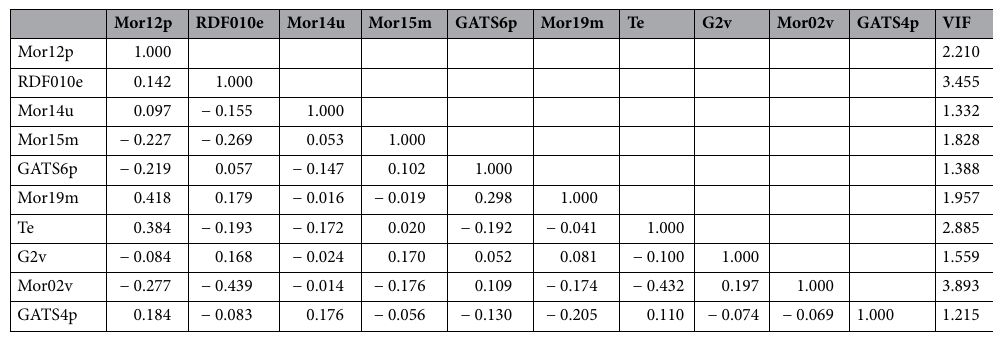
Table 5. The correlation coefficient of descriptors and corresponding VIF values based on model 1 (Eq.